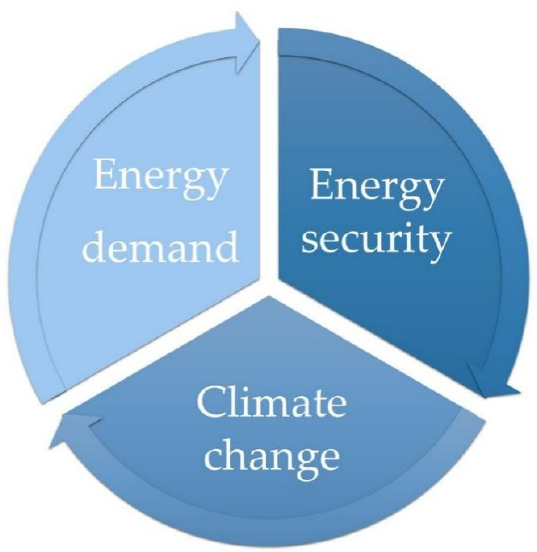
Figure 1. Three main reasons to develop the production of biofuels.